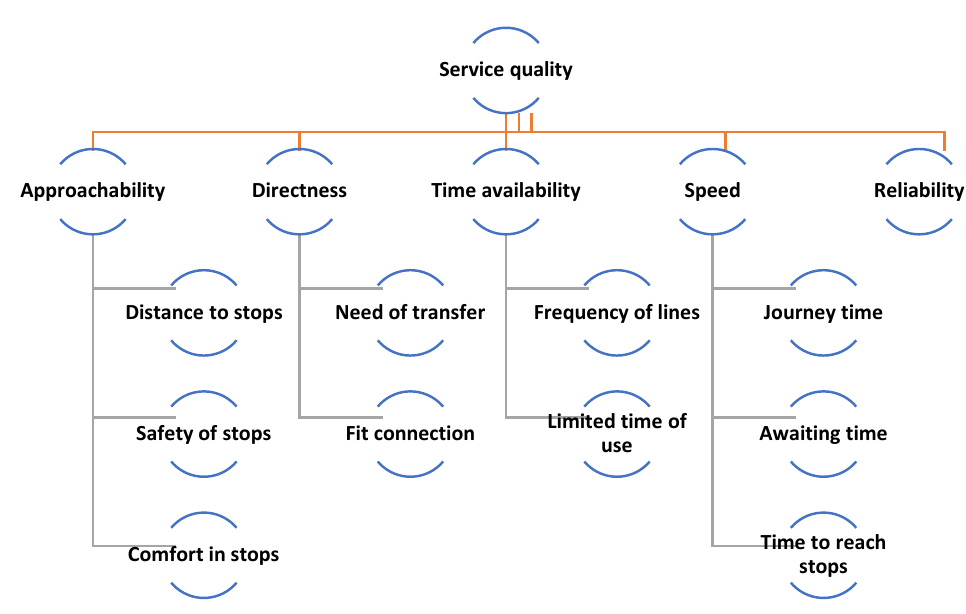
Figure 2. The hierarchical model of the service quality.